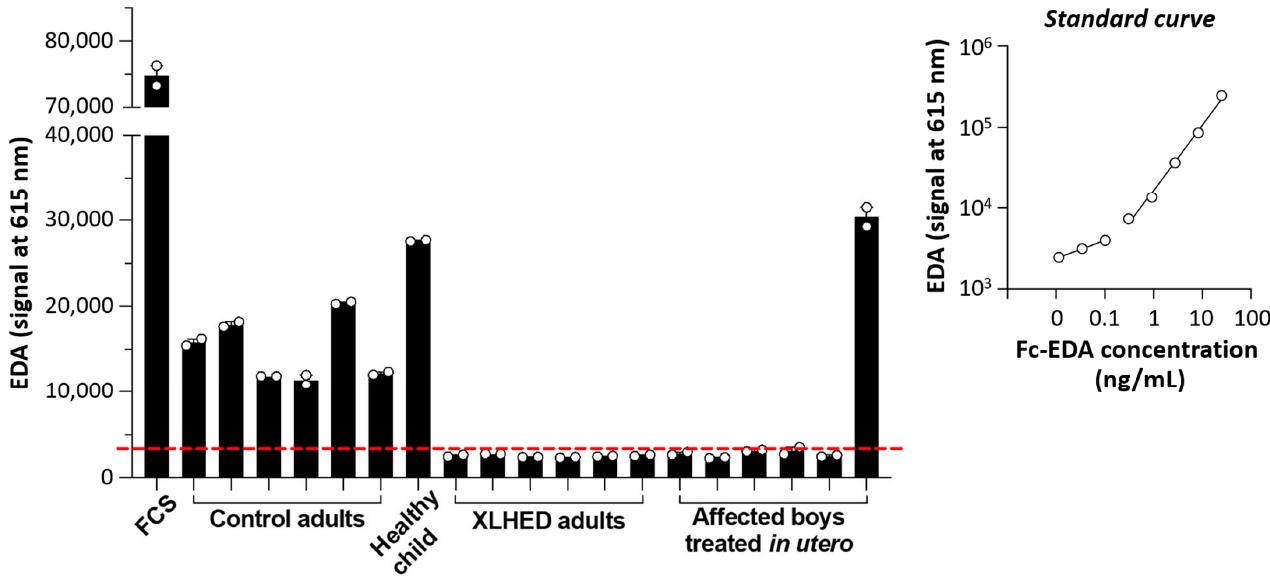
Figure 4. Levels of circulating EDA as determined by AlphaLisa. The measurements, always conducted in duplicates, were reproducible in three independent experiments. A representative assay is shown here. Signals below the dashed red line are considered as background. The standard curve was generated with Fc-EDA diluted in serum from an adult male subject with XLHED. FCS, fetal calf serum.